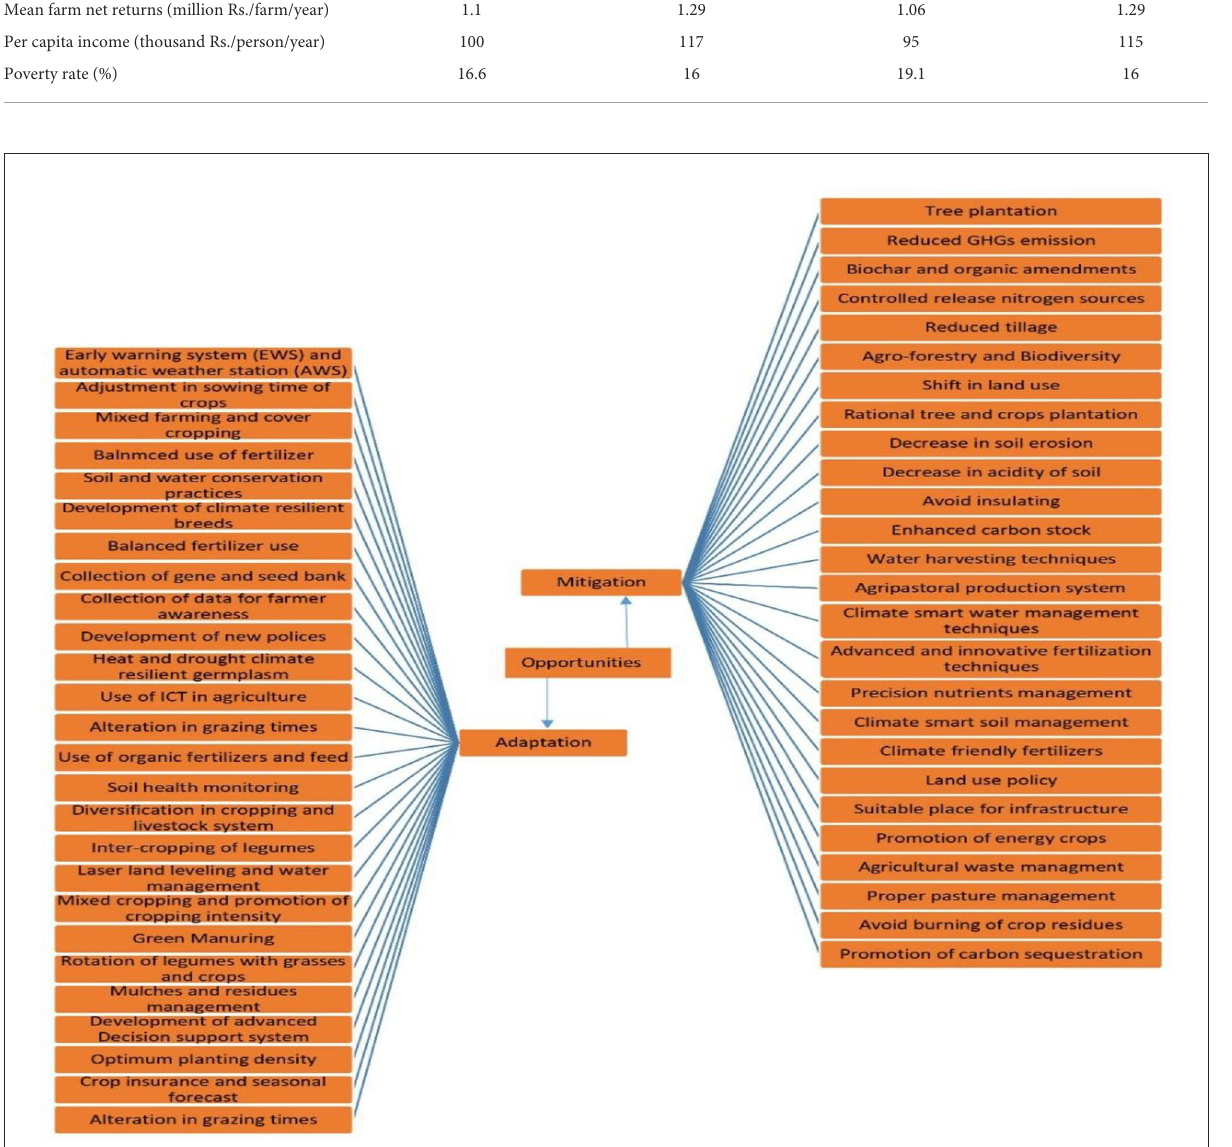
erosions, managing the acidity of the soil, and implementing crop rotation. By increasing grazing duration and rotational grazing of pastureland, sequestration of carbon can be achieved (Runkle et al., 2018). About 0.15 gigatonnes of CO 2 equal to the amount of CO 2 produced in 1 year globally, can be sequestered